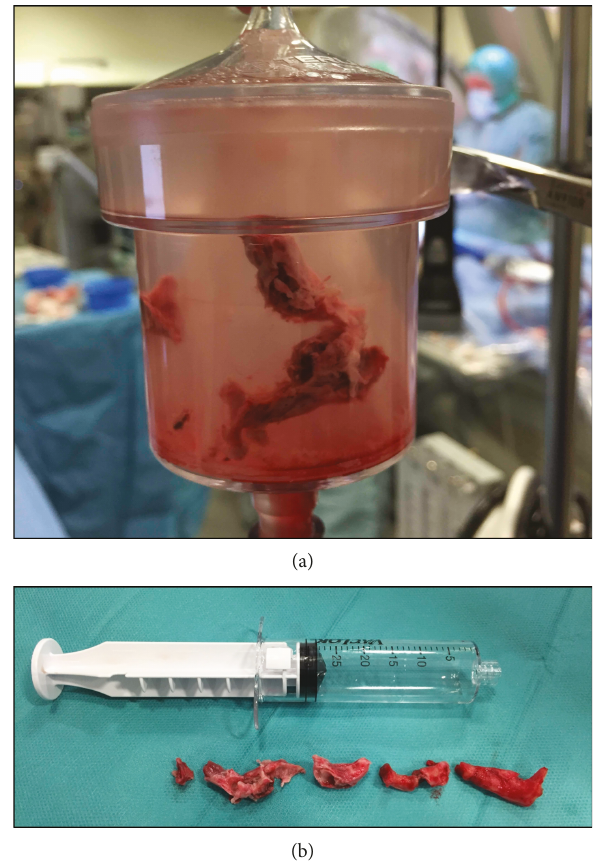
Figure 1: (a) Photo of removed thrombus trapped in the fi lter. (b) Photo of all removed thrombus